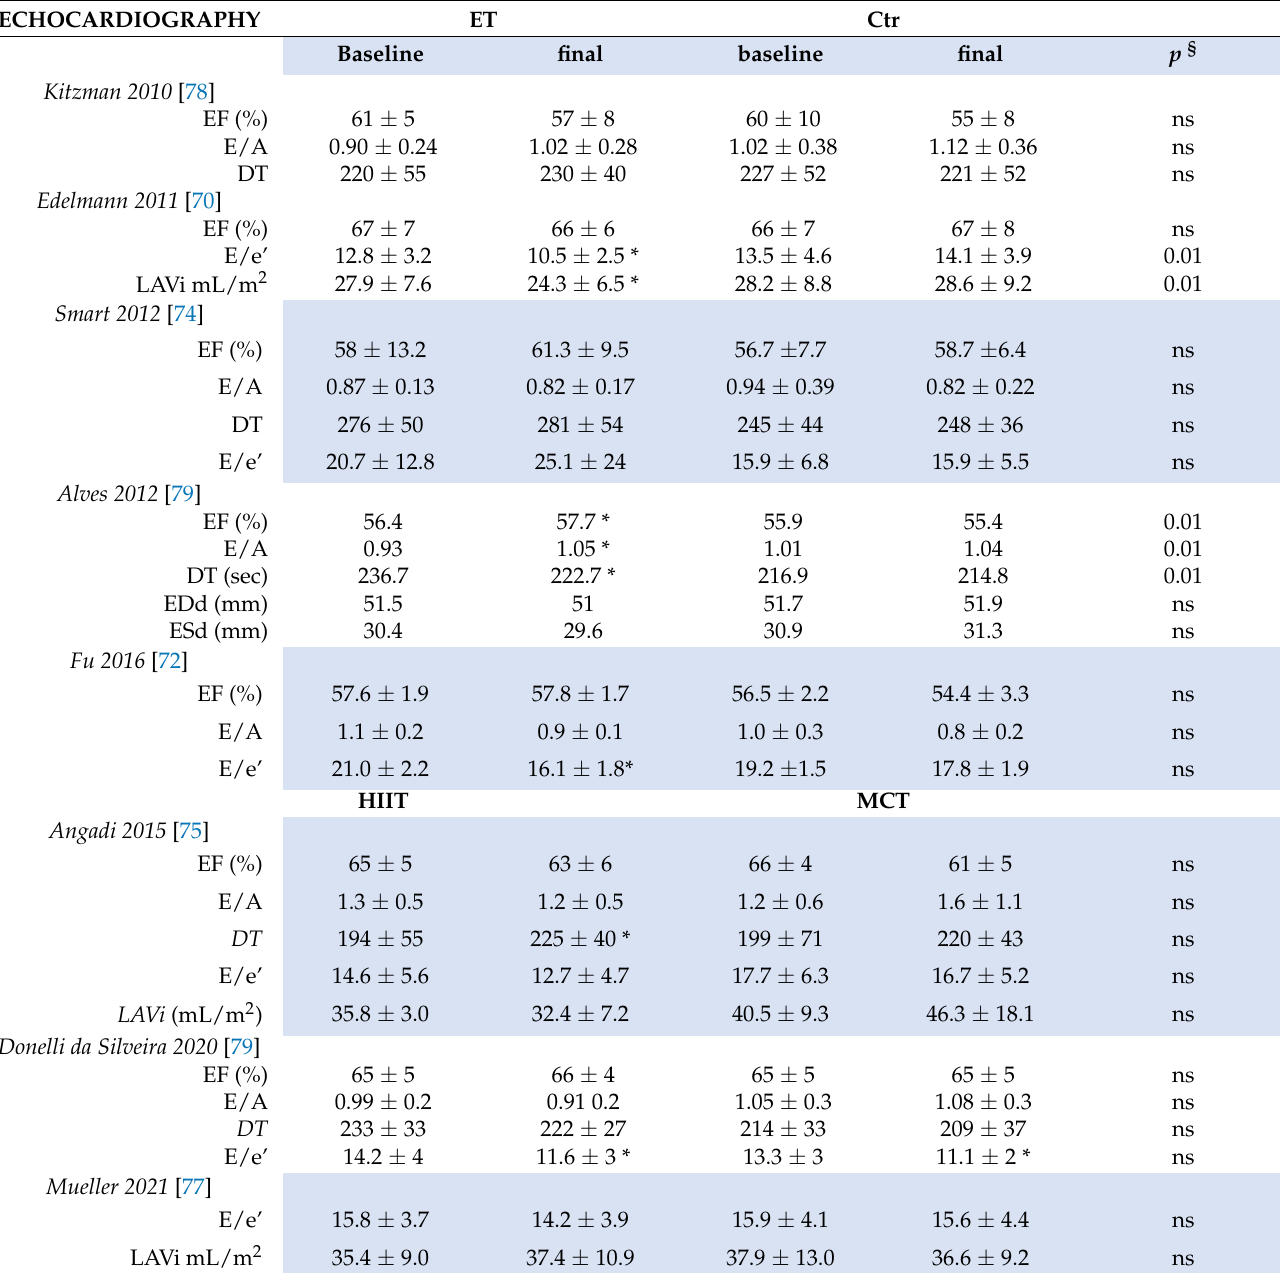
Table 5. Results of trials investigating the effects on echocardiographic parameters of exercise training in